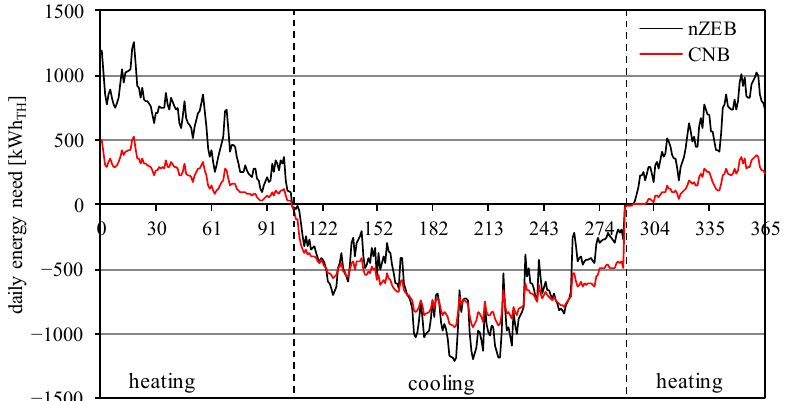
Figure 7. Net and gross daily thermal energy need profiles for the nZEB and CNB building models.